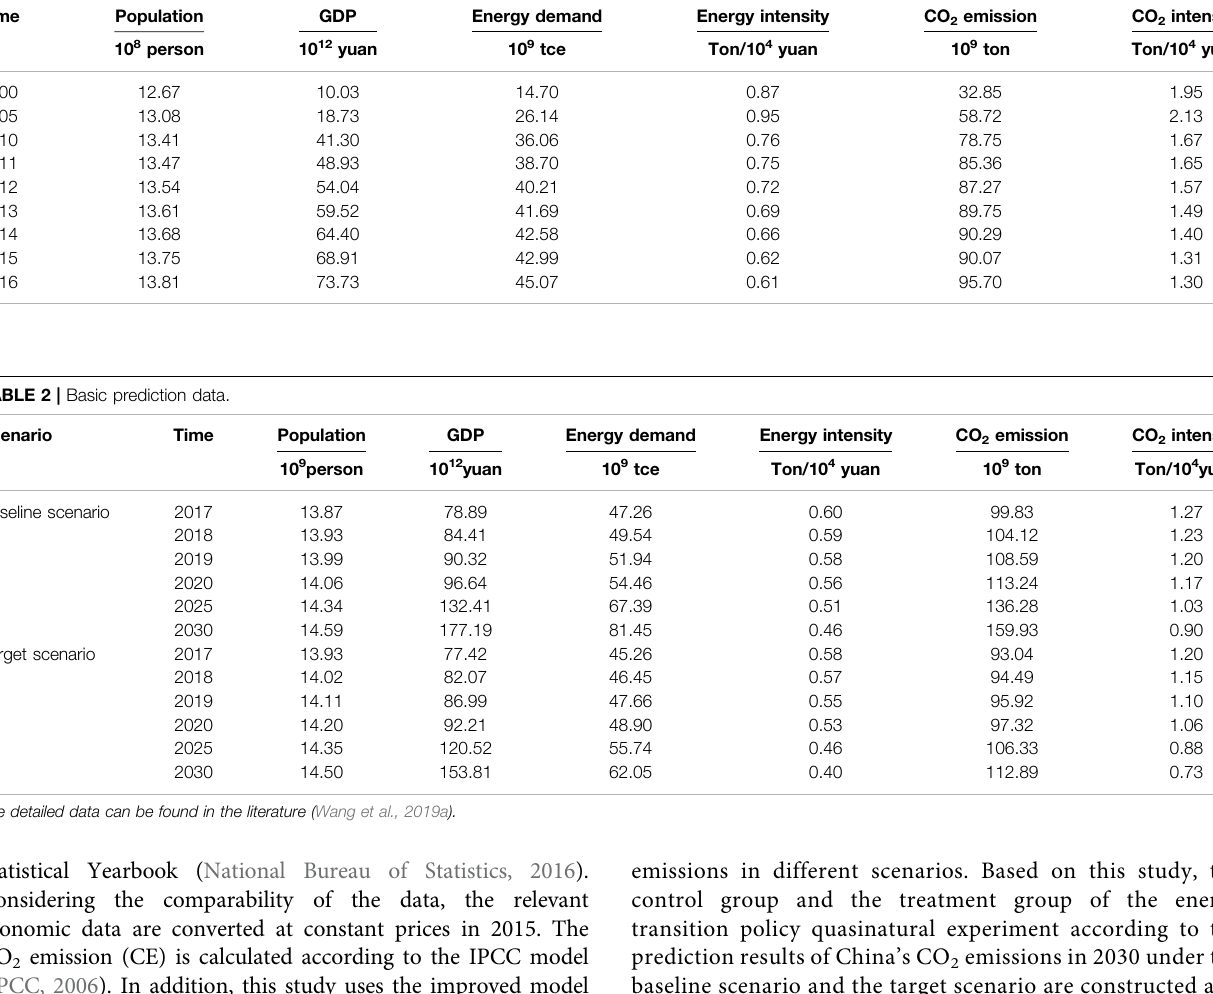
TABLE 1 | Basic historical data. Time